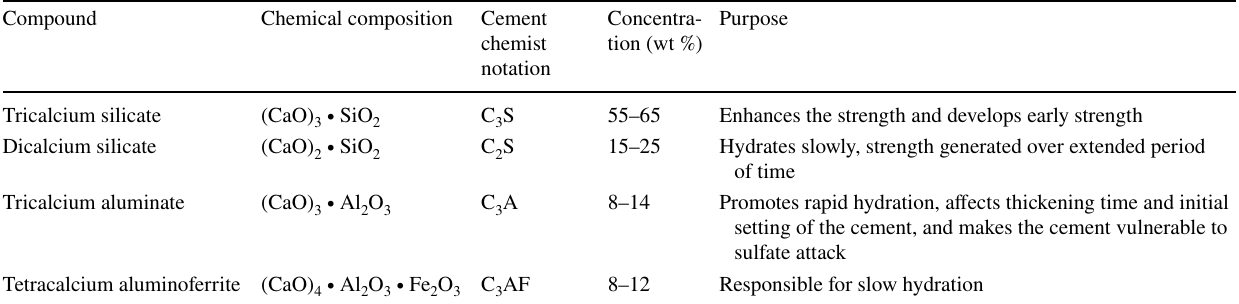
Table 1 Major components of Portland cement (modified from Adams and Charrier 1985) Compound Chemical